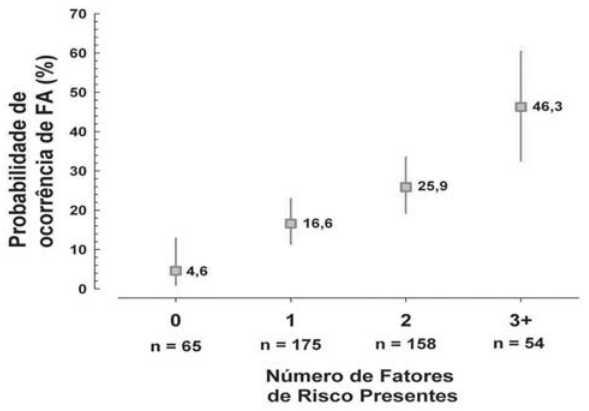
Fig. 1 - Aumento do risco (expresso em %) para a ocorrência de FA pós-operatória de acordo com o número de fatores de risco presentes. As barras representam intervalo de confiança de 95% (P< 0,001)